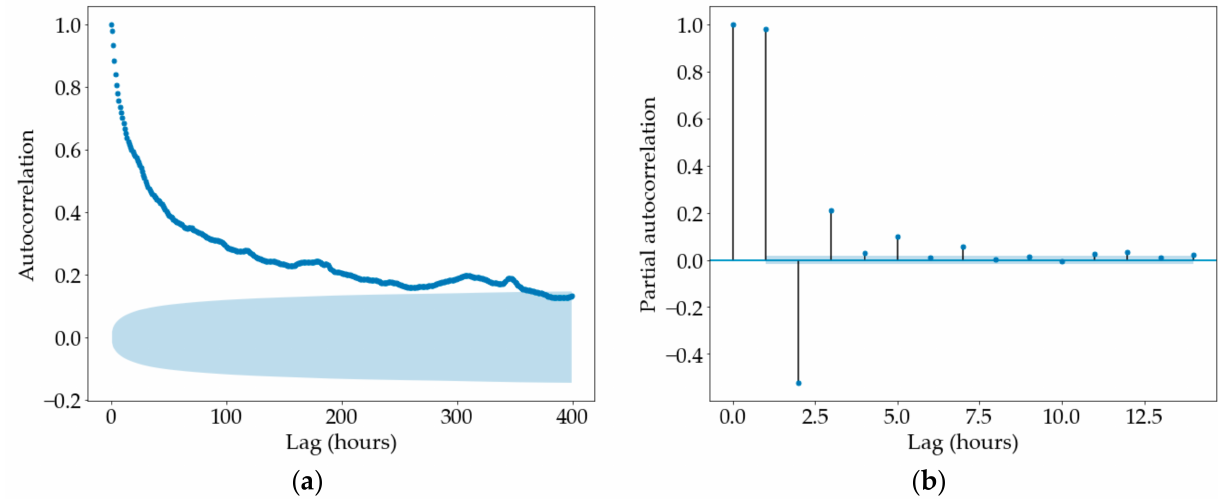
Figure 3. ( a ) Temporal autocorrelation and ( b ) partial autocorrelation function of the runoff time series. The blue hatch indicates the 95% confidence